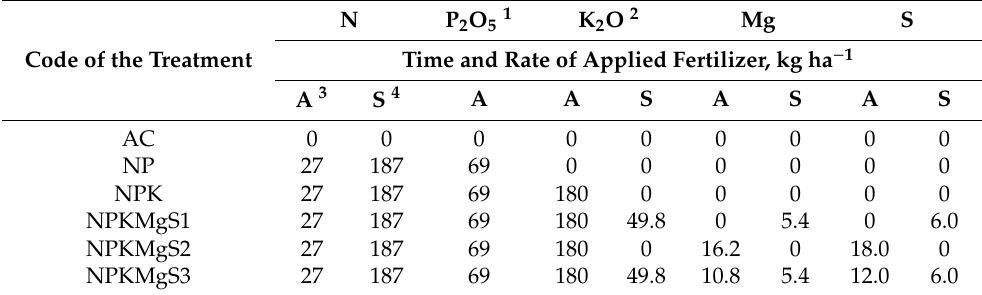
Table 2. Experimental design: composition, rates and timing of fertilization